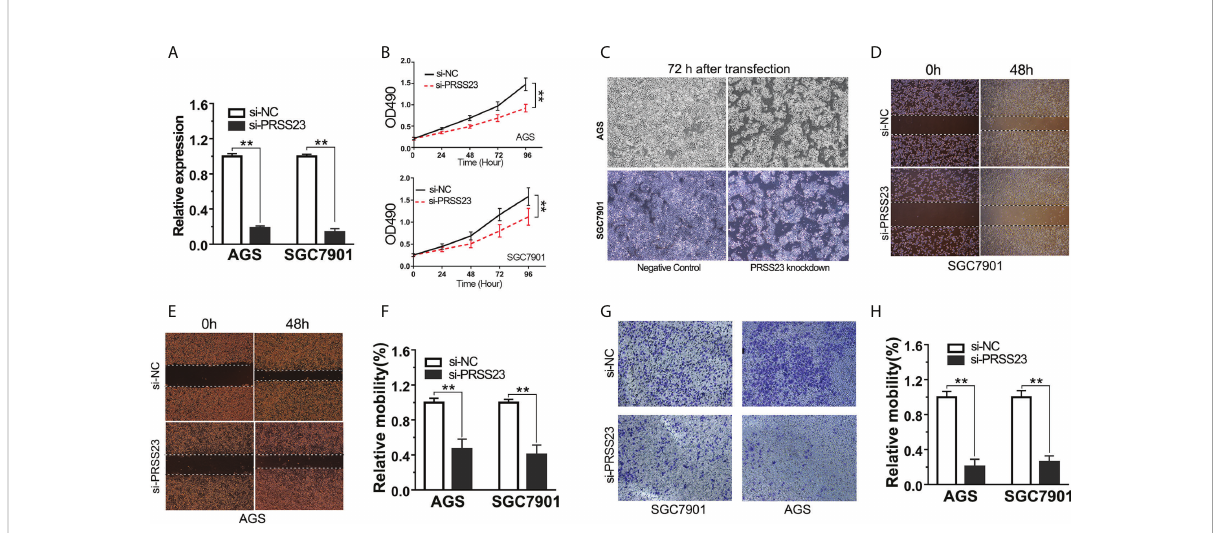
FIGURE 3 PRSS23 knockdown signi fi cantly decreased GC cell proliferation and invasion. (A) The ef fi ciency of PRSS23 knockdown was determined in GC cell lines. (B) The effect of PRSS23 knockdown on GC cell growth was determined by MTT assay. (C) The morphology of gastric cancer cells after knockdown of PRSS23 for 72 hours. (D, E) Wound healing assays showed that PRSS23 knockdown inhibits GC cells migration. (F) The statistical data of the migrated cells. (G) The effects of PRSS23 knockdown on GC cells invasion were assessed by transwell assays. (H) The statistical data of the invasive cells. **, P <